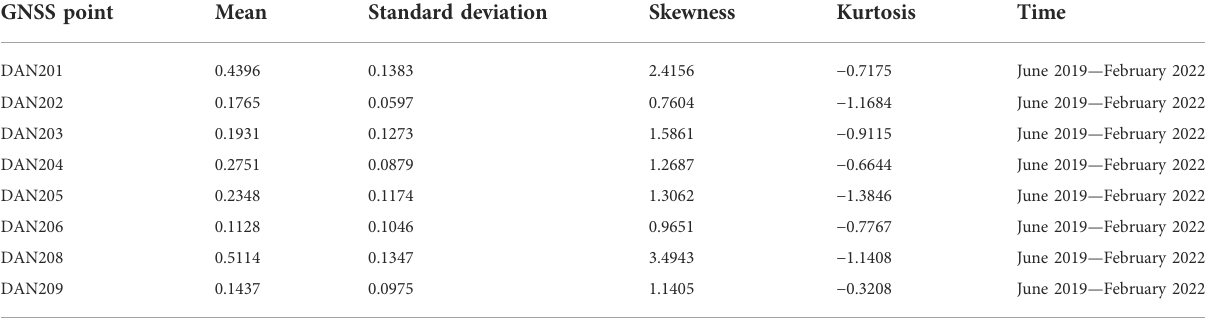
TABLE 1 Summary of the daily instant subsidence monitoring dataset.